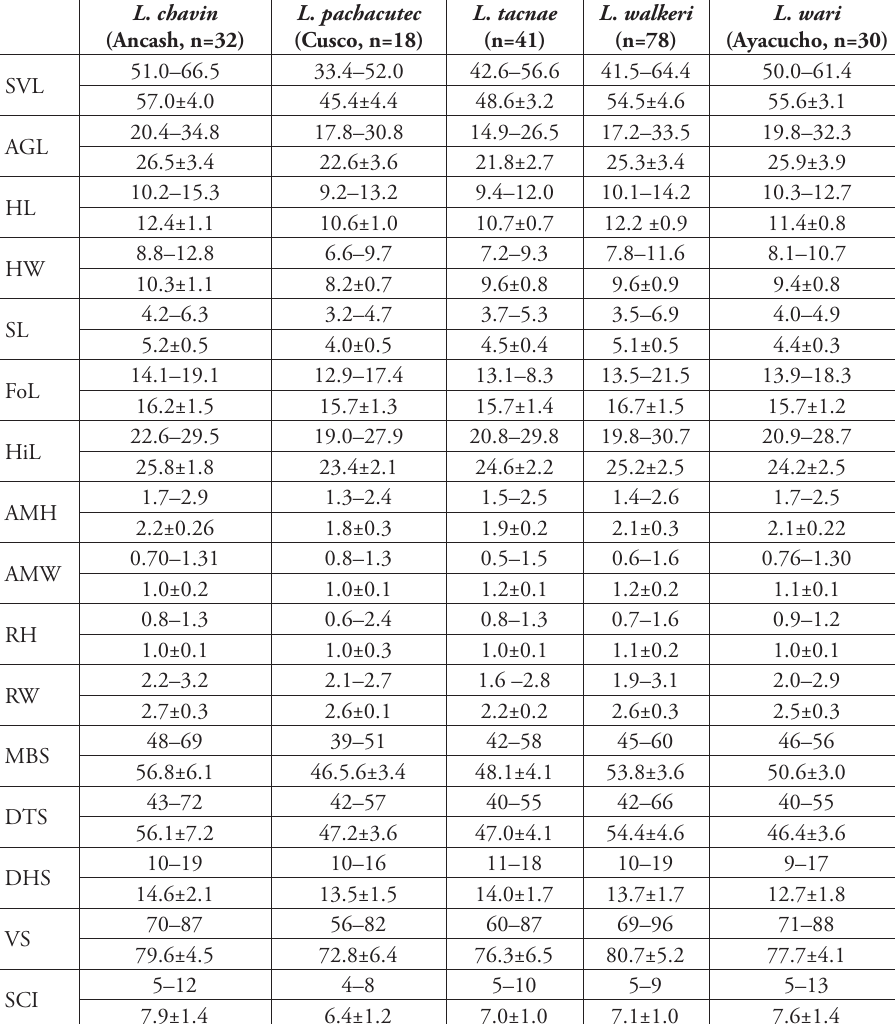
table 2. Descriptive statistics of morphometric and meristic characters for three new species of Liolaemus described herein, and L. tacnae and L. walkeri . First rows show ranges and second rows show means and standard deviations. See methods for